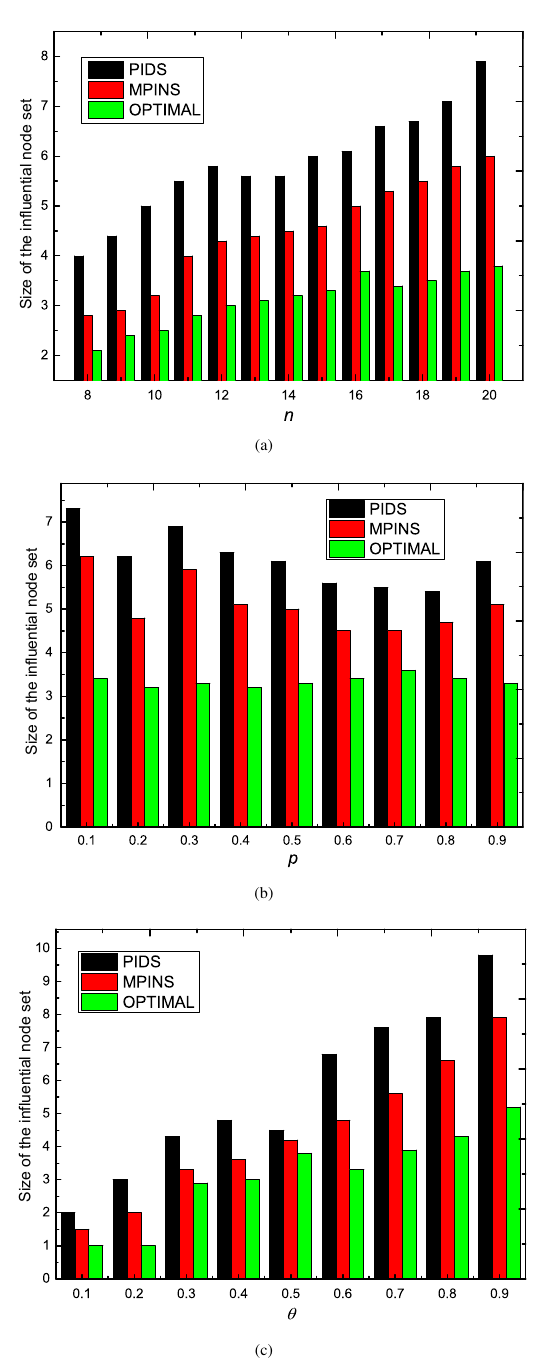
Fig. 4 Size of solutions on small scale networks. The default settings are n = 15, p = 0.5, and (cid:18)(cid:18)(cid:18) =